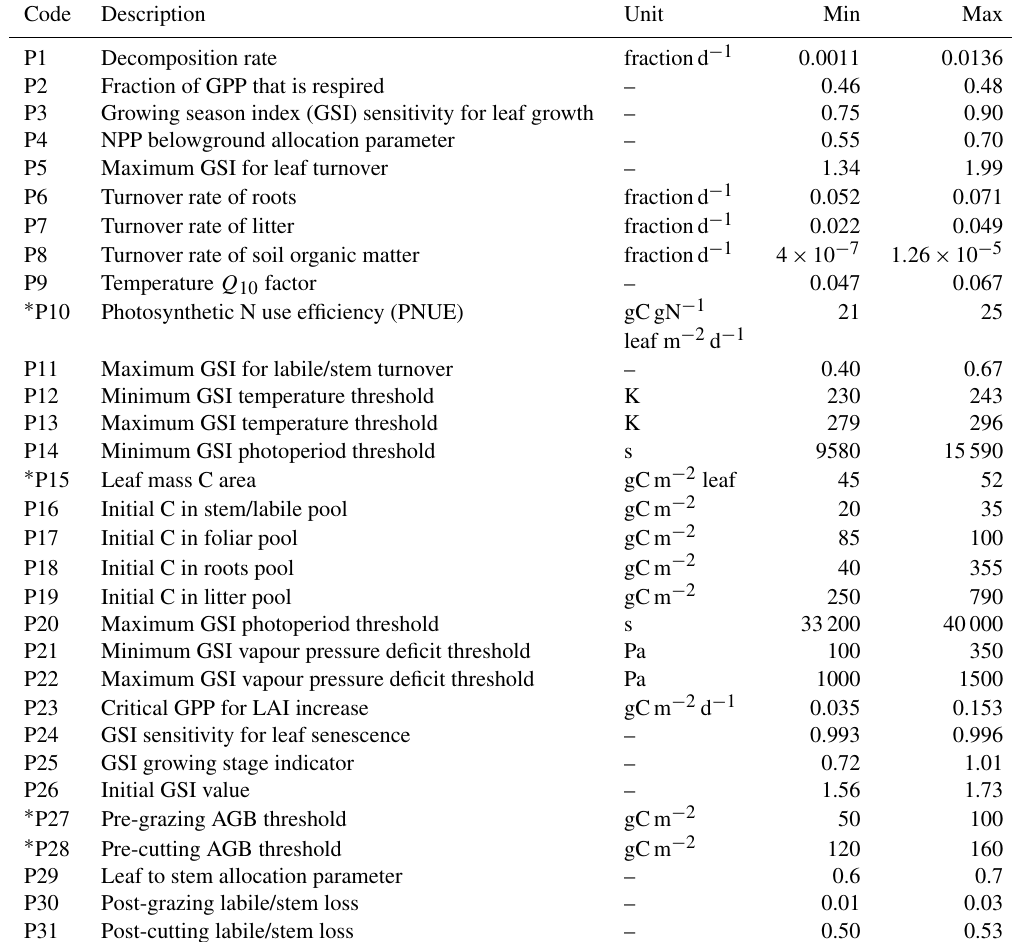
Table A1. DALEC-Grass parameters (number, description, units and prior min/max values).